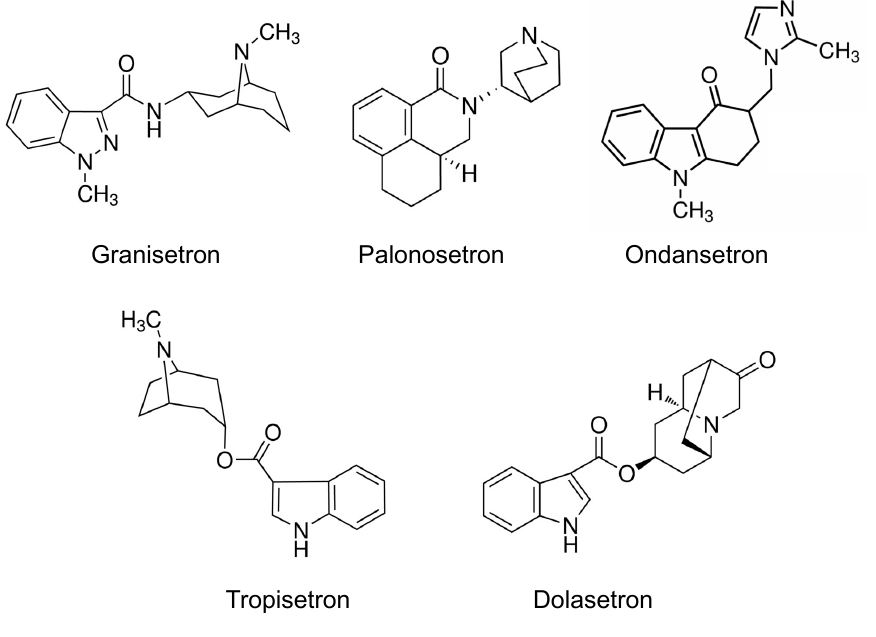
Figure 1. Structure of 5-HT 3 antagonists.